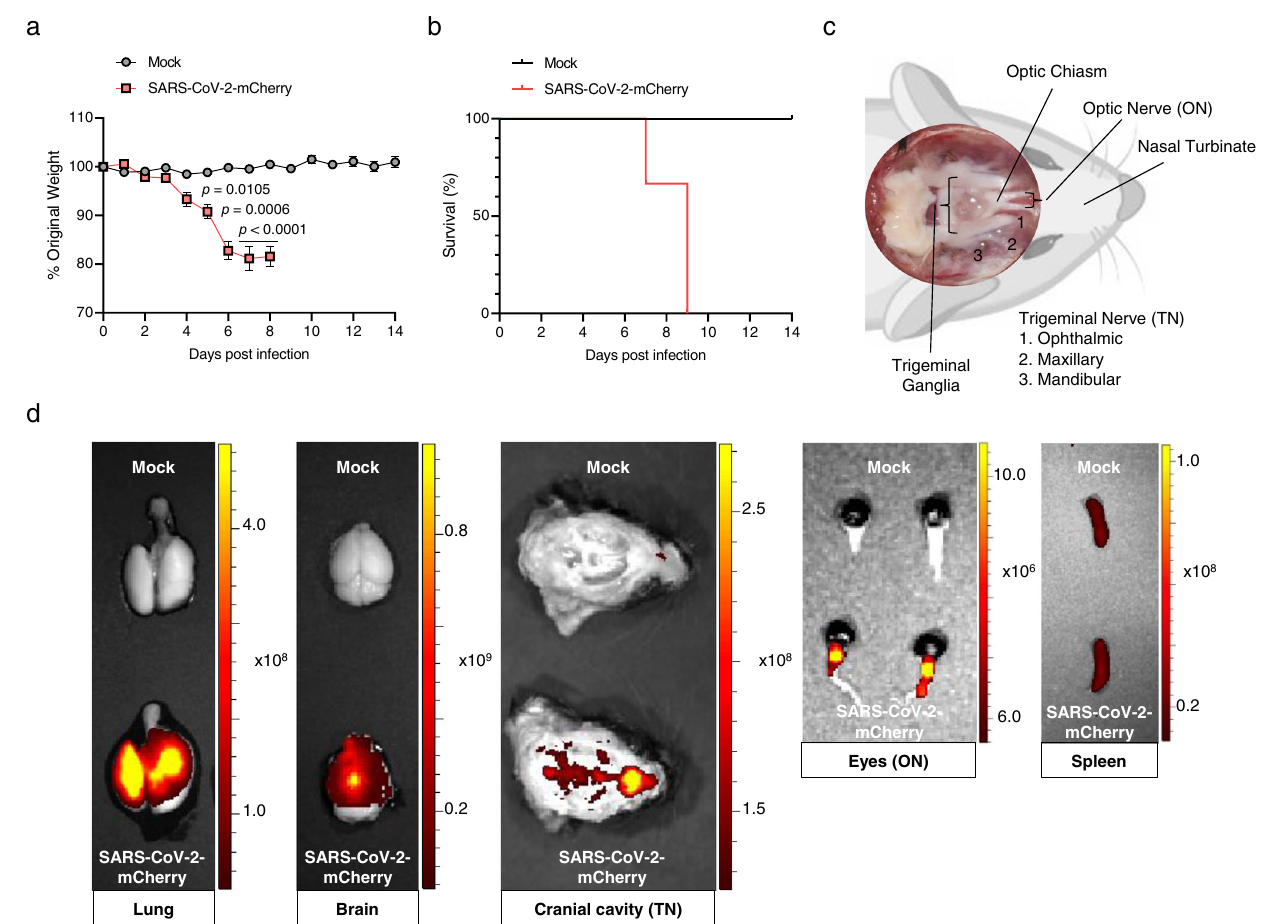
Fig. 5 | In vivo viral distributions of infectious SARS-CoV-2-mCherry in IN- infected mice. K18-hACE2 mice were IN-inoculated with 10 4 PFU of SARS-CoV-2- mCherry ( n =6 for the mock-infected and infected mice, respectively). a , b Body weight ( a ) and survival( b ) were monitored at the indicateddpi (Mock,grey; SARS- CoV-2-mCherry, red). Symbols represent means±SEM. Statistically signi fi cant dif- ferencesbetweenthegroupsweredeterminedusingmultipletwo-tailed t -tests. c A brain-dissecteddorsalviewofthemurinecranialcavityshowingopticnerves,optic chiasma, trigeminalganglia andtrigeminalbranches (1, ophthalmic;2,maxillary;3,